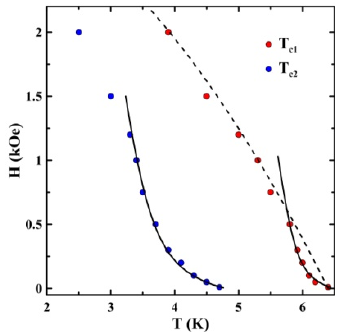
Figure 4. The superconducting-phase diagram obtained from magnetic measurements. The dashed line is a two-fluid model fit. Solid lines show fitting using Equation (13) from [16].